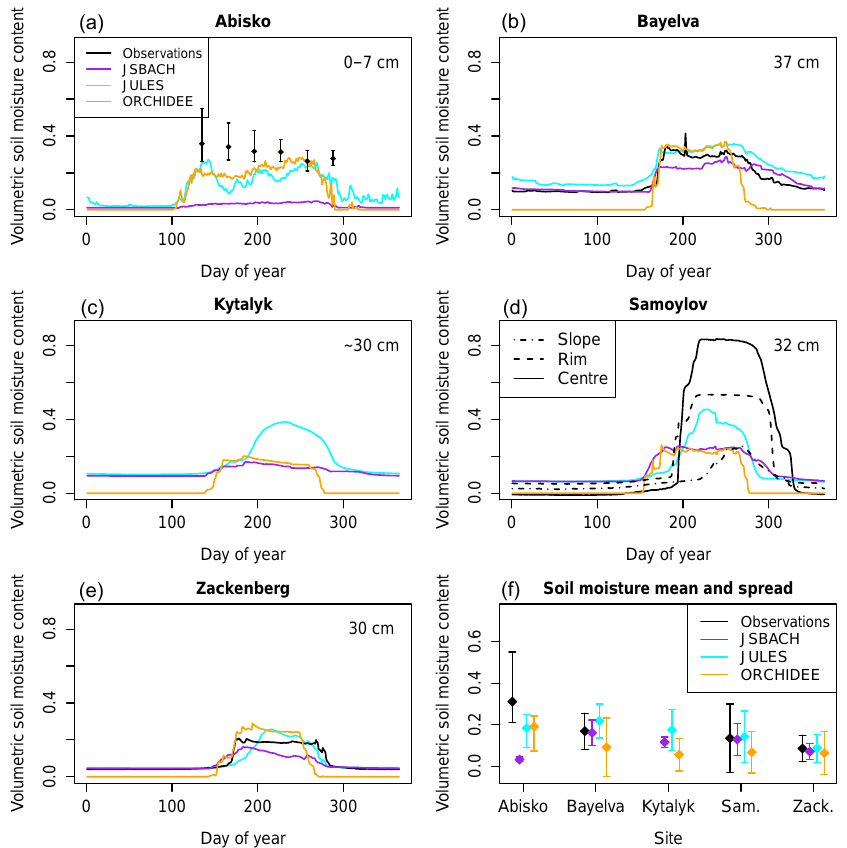
Figure 3. Mean annual cycle of unfrozen soil moisture at each site, showing both observations (where available) and models. Depths are as follows: JSBACH: 19cm for all sites (this is the closest to 30cm – the next layer is at 78cm), except Abisko, which is 3cm. JULES: 32cm (except Abisko, which is 3cm). ORCHIDEE: 36cm (except Abisko, which is 4cm). Observations: Bayelva: 37cm; Samoylov: 32cm; Zackenberg: 30cm; Abisko: 0–7cm. For Samoylov, three different soil moisture profiles are shown that represent different parts of the polygonal microtopography. In panel (f) , Samoylov and Zackenberg are abbreviated to “Sam.” and “Zack.”. See Supplement Table S1 for the years used at each